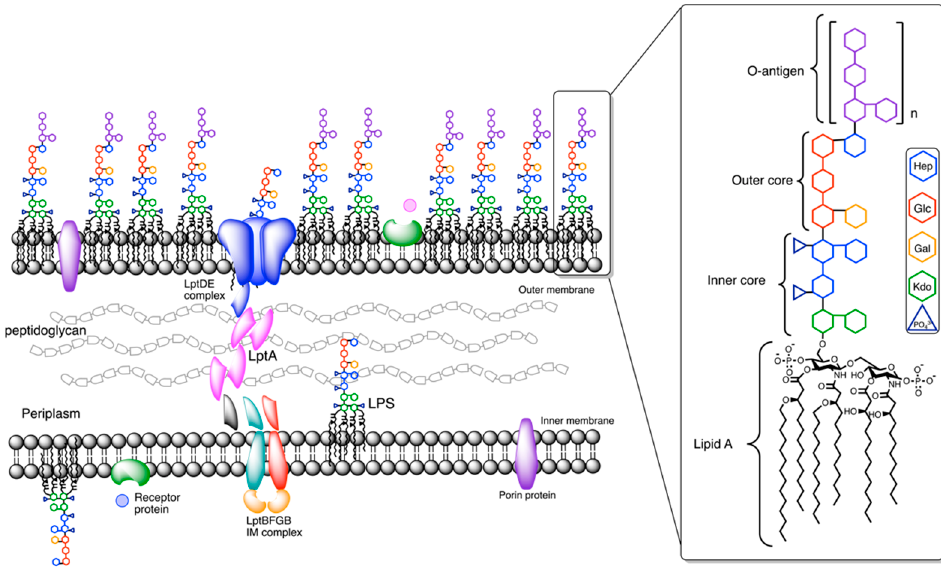
Figure 1. Bacterial lipid bilayer with LPS transfer protein complex and the full LPS structure (inset). Furthermore, xenobiotics including Polymyxin B and metal ions, have been shown to trigger alterations of LPS structure to further fortify the outer membrane [6,7]. Additionally, previous studies have shown that removing genes involved in the inner core oligosaccharide biosynthesis, including Heptosyltransferase I (HepI), results in increased bacterial antibiotic susceptibility and an expression of a deep-rough LPS morphology [8], which makes HepI a target of interest for Gram-negative antibacterial therapeutic design. As shown in Figure 2, HepI transfers a heptose moiety from ADP- L - glycero - D - manno -heptose (ADPH) to Kdo 2 -Lipid A (KLA) in a nucleophilic substitution reaction. Kinetic characterization of the HepI reaction, which is enabled by detection of the ADP produced during the reaction via a UV-Vis coupled spectrophotometric assay with putative inhibitors, as well as biophysical characterization of HepI including circular dichroism spectroscopy, small-angle x-ray scattering, intrinsic tryptophan fluorescence, and isothermal titration calorimetry all require significant quantities of purified ADPH and KLA [9–12]. NH 2 N NNN